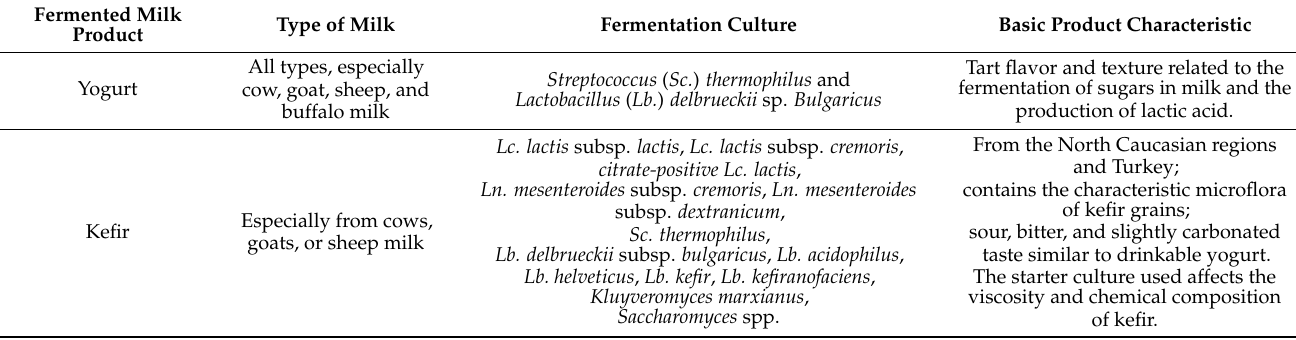
Table 2. Characteristics of selected fermented milk products